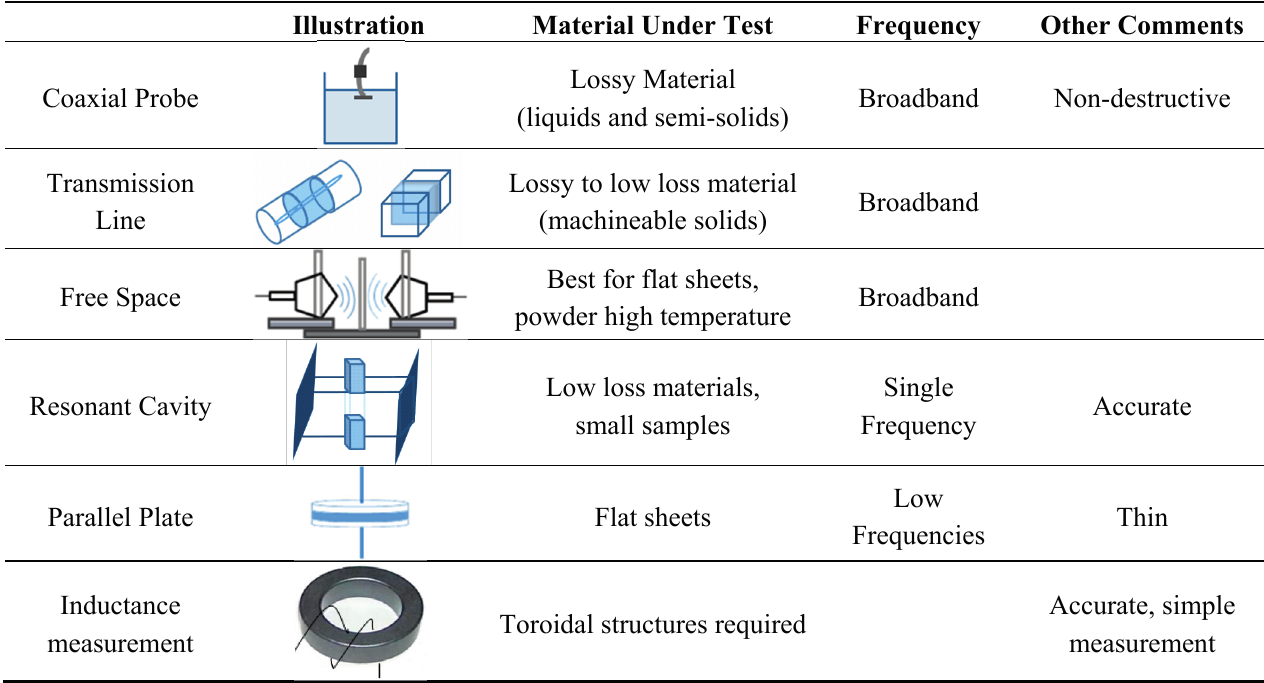
Table 2. Material measurement